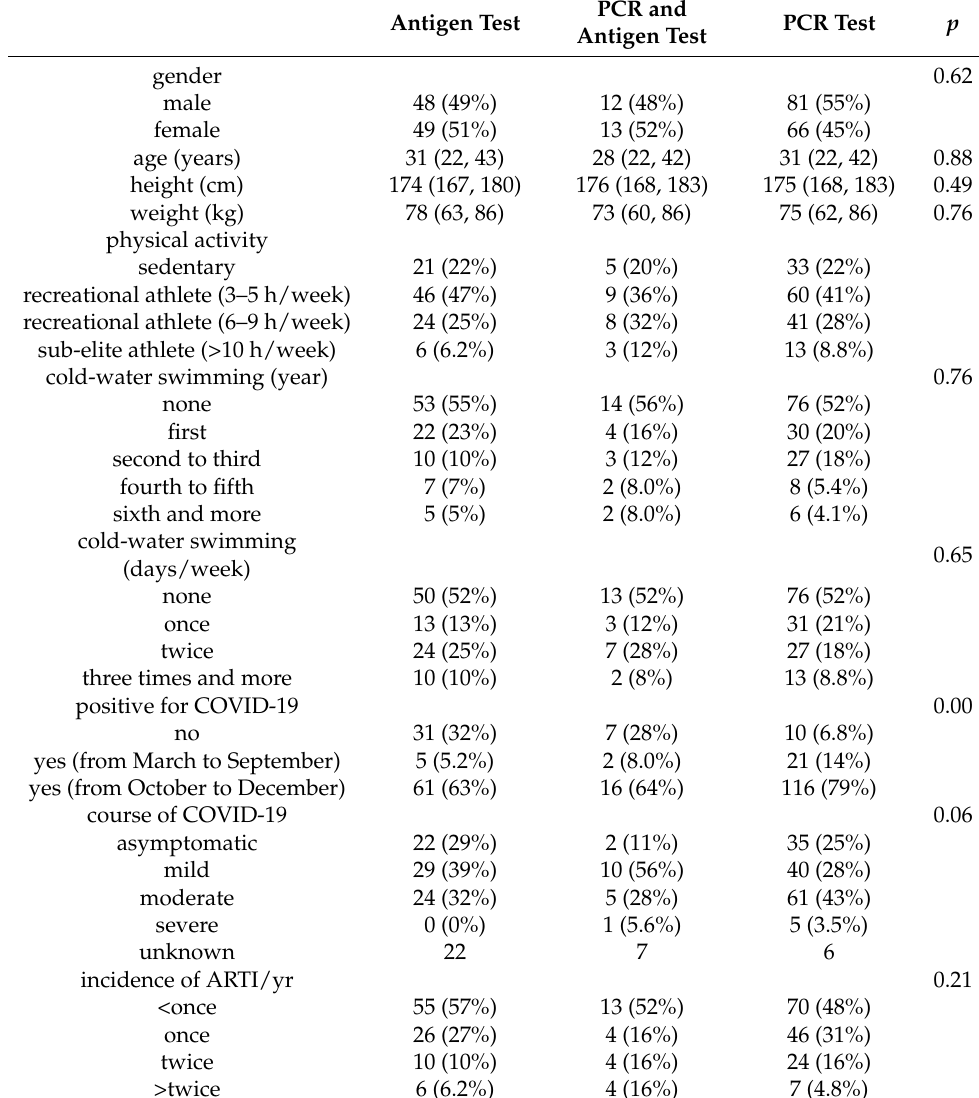
Table 2. Data distribution with respect to diagnostic test used for detecting COVID-19 ( n =